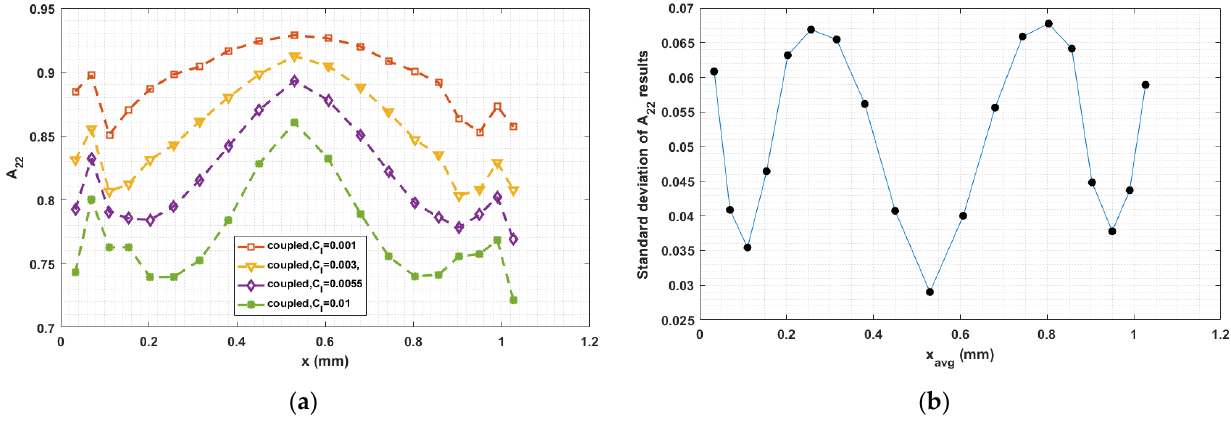
Figure 21. ( a ) Fiber orientation tensor component A 22 at nozzle exit; ( b ) standard deviation of the parametric study resulted A 11 versus the averaged x